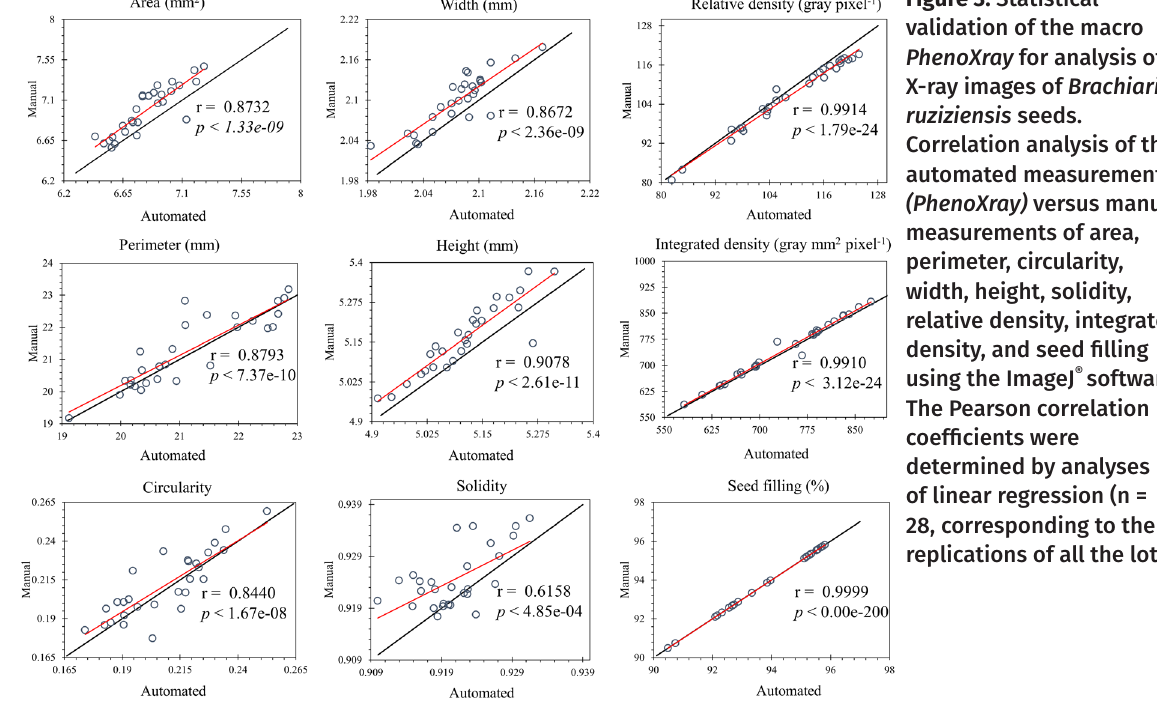
Figure 3. Statistical validation of the macro PhenoXray for analysis of X-ray images of Brachiaria ruziziensis seeds. Correlation analysis of the automated measurements (PhenoXray) versus manual measurements of area, perimeter, circularity, width, height, solidity, relative density, integrated density, and seed filling using the ImageJ ® software. The Pearson correlation coefficients were determined by analyses of linear regression (n = 28, corresponding to the replications of all the